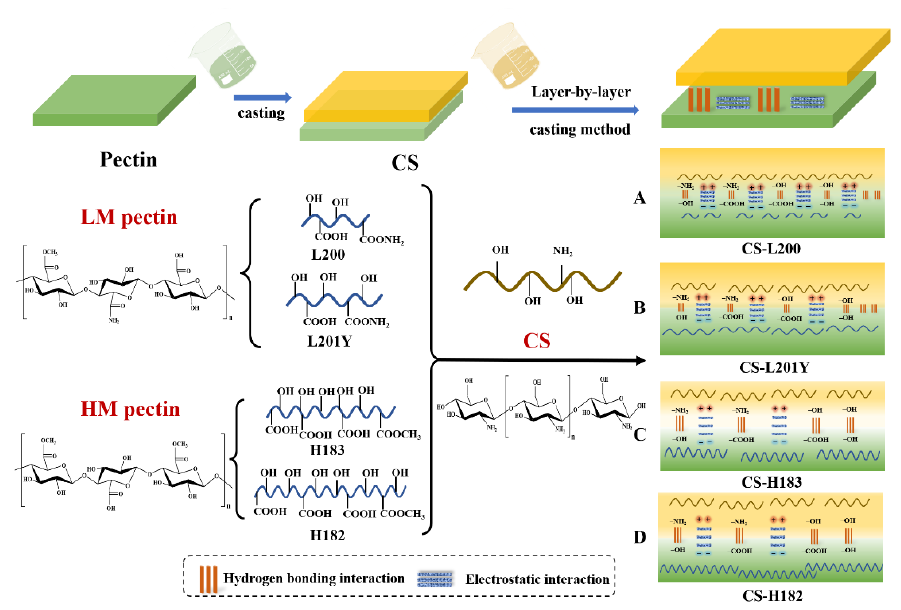
Figure 7. Schematic illustration of polyelectrolyte assembly mechanism among CS and pectin (( A ): CS-L200, ( B ): CS-L201Y, ( C ): CS-H183, ( D ):